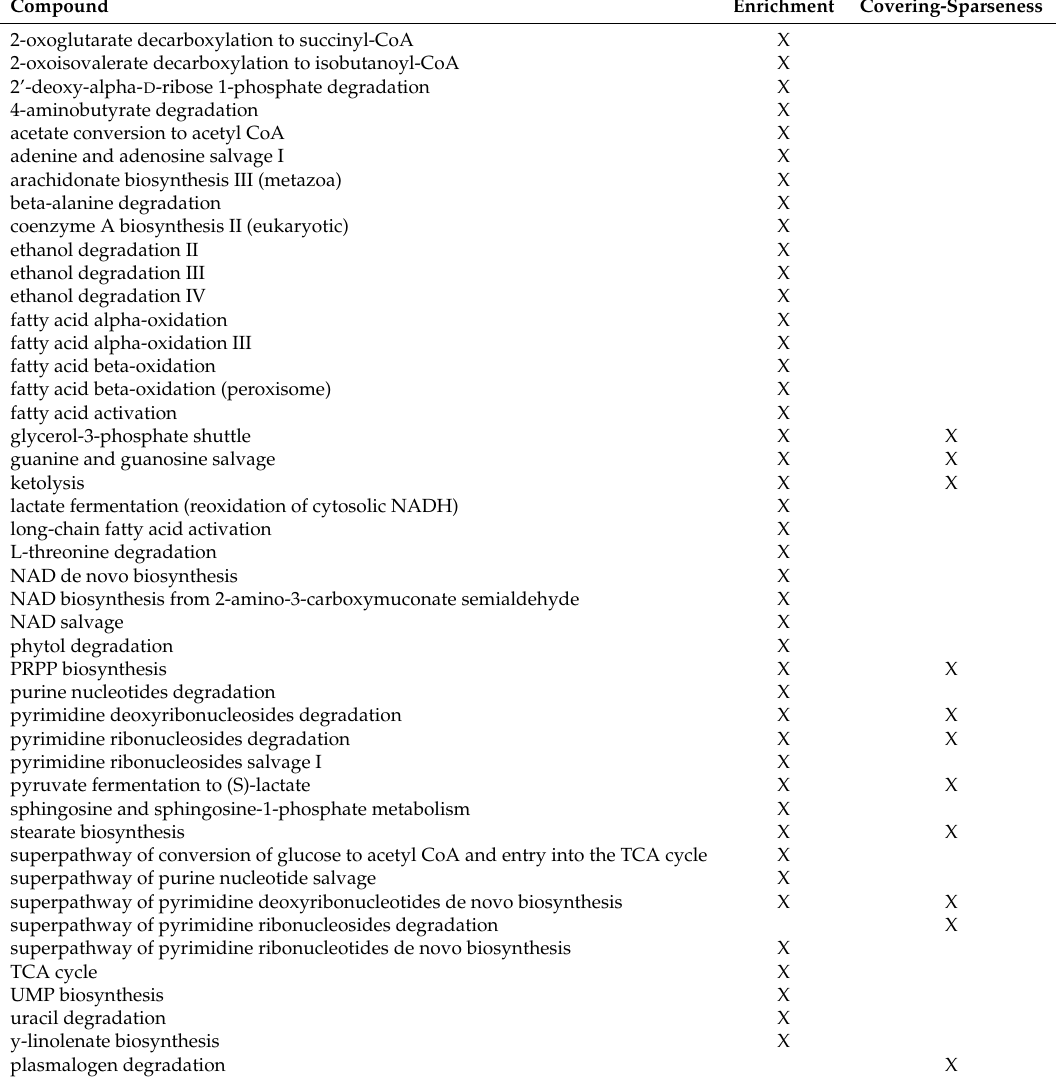
Table 10. Comparison of McDonnell Pathway Enrichment to Pathway Covering using Covered Compound